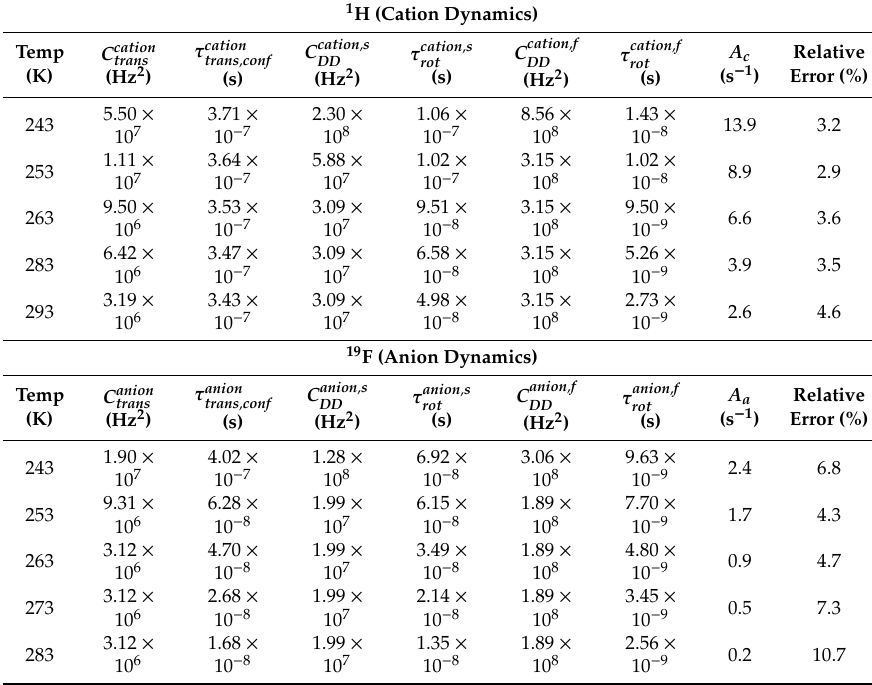
Table 2. Parameters obtained from the analysis of 1 H and 19 F spin–lattice relaxation data forEMIM-FSI in